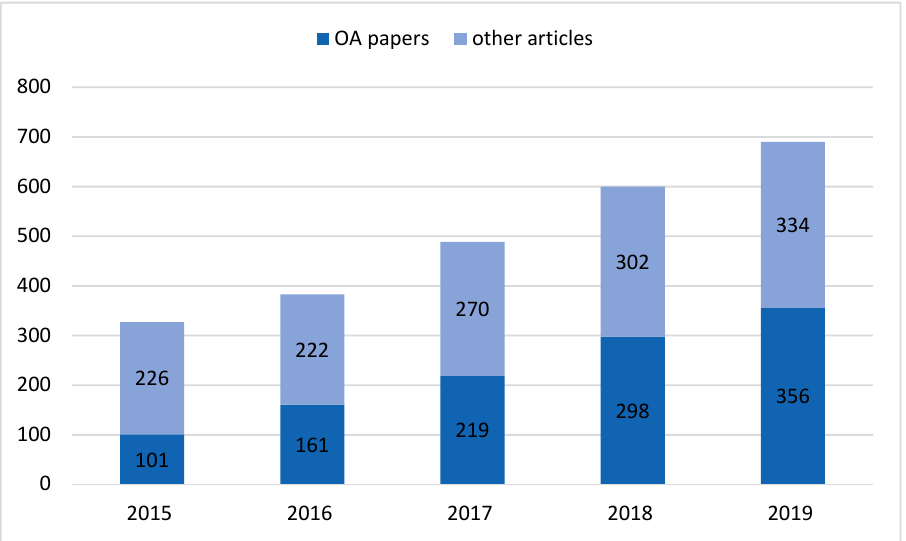
Figure 8. Open access (OA) and other articles 2015–2019 ( n = 2489). Table 9. The journals with the highest number and share of OA articles ( n = 1135).